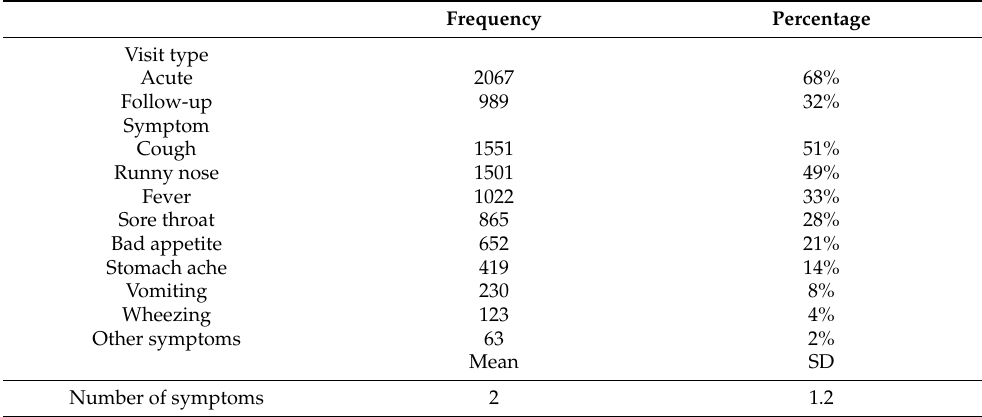
Table 3. Clinical characteristics of medical visits.